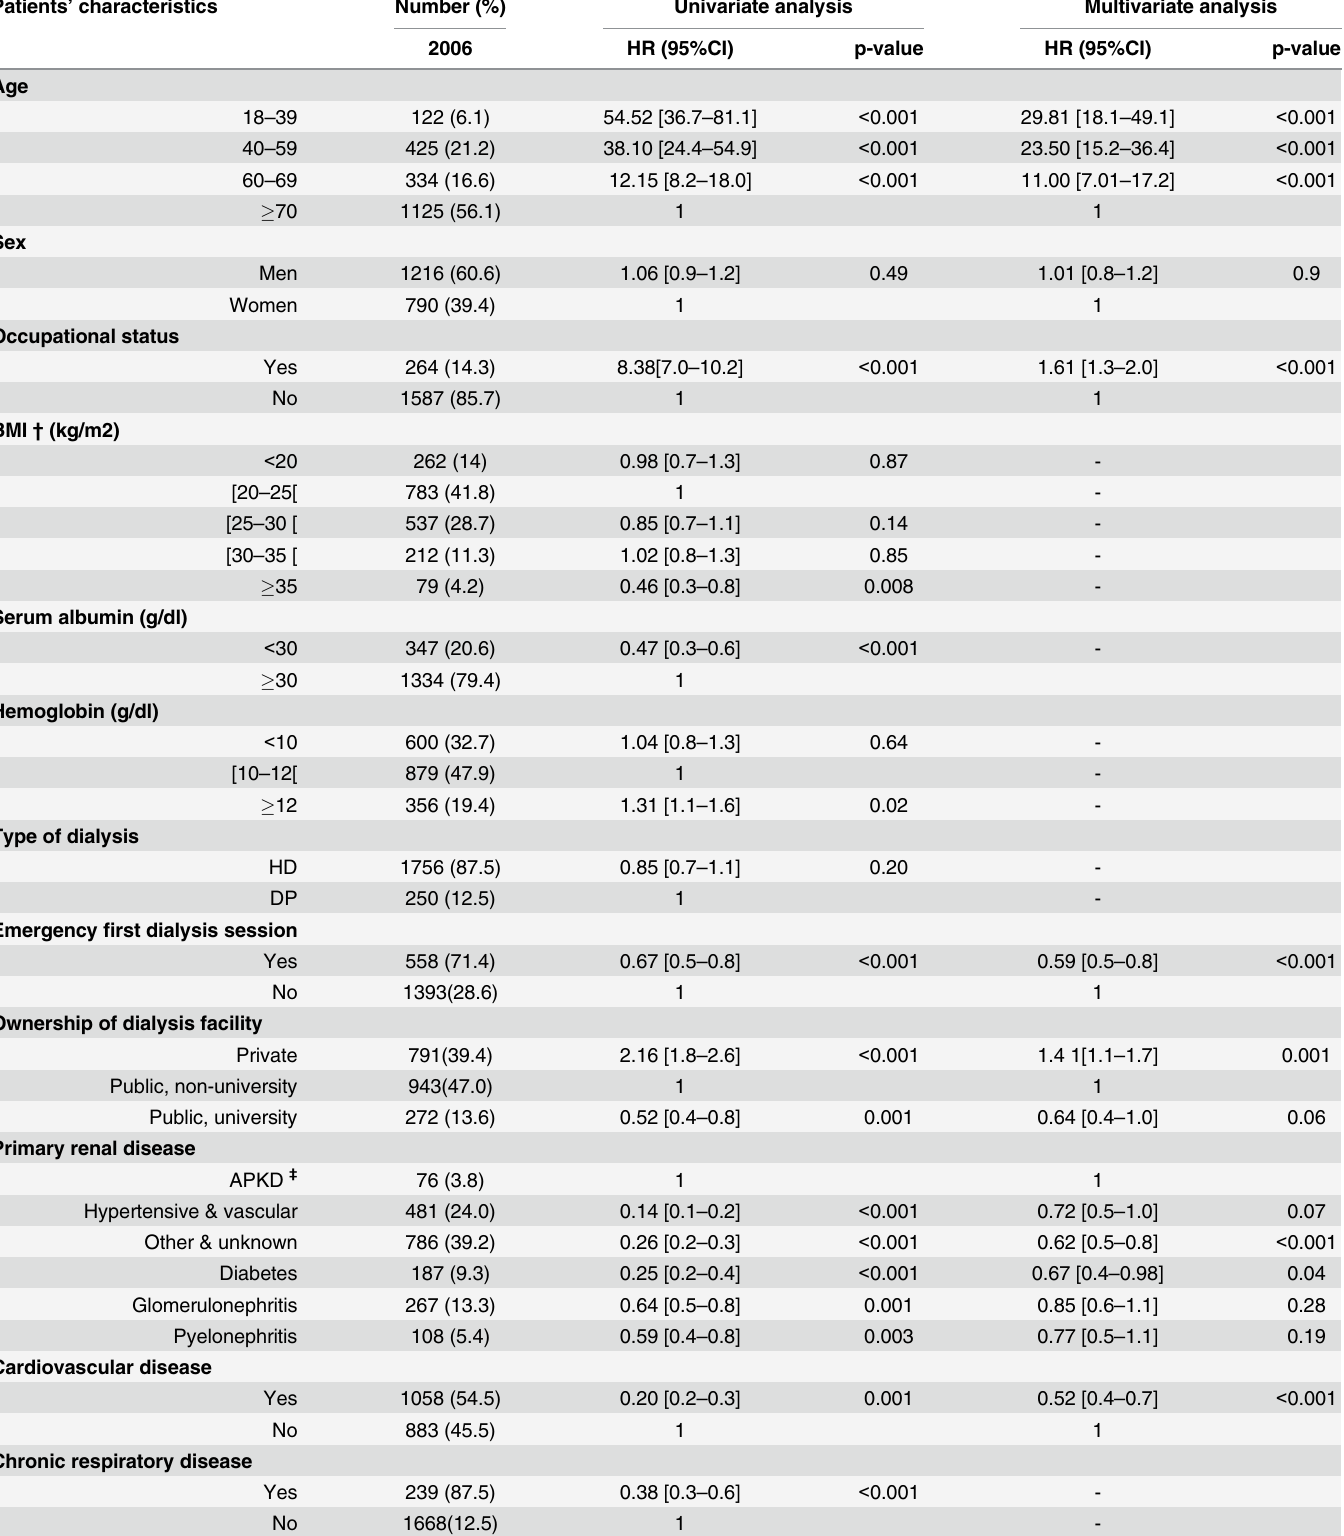
Table 1. Patients ’ characteristics at first dialysis and their association with access to the waiting list (univariate and multivariate Cox analyses). Patients ’